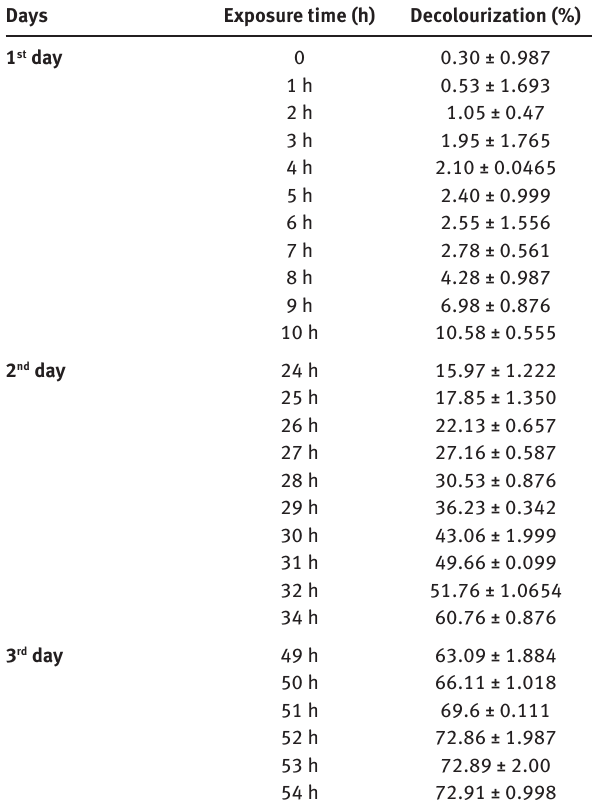
Table 1: Decolorization (%) of dyes present in industrial wastewater by biosynthesized silver nanoparticles analyzed for three days.